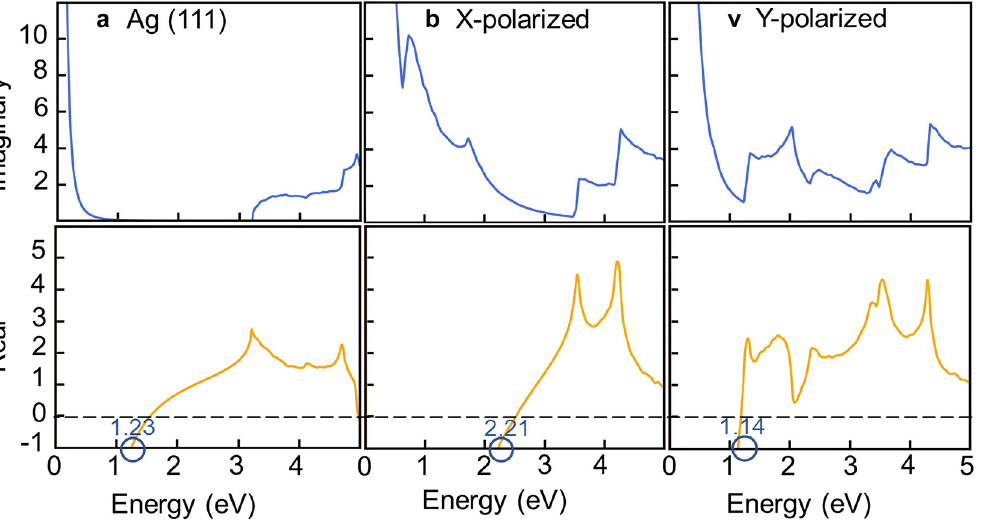
Figure 4: Imaginary and real parts of the complex dielectric function, as a function of photon energy, in Ag(111) monolayer (a) and borophene monolayer for X-polarized light (b) and Y-polarized light (c). The circles indicate the values of surface plasmon frequency ω sp